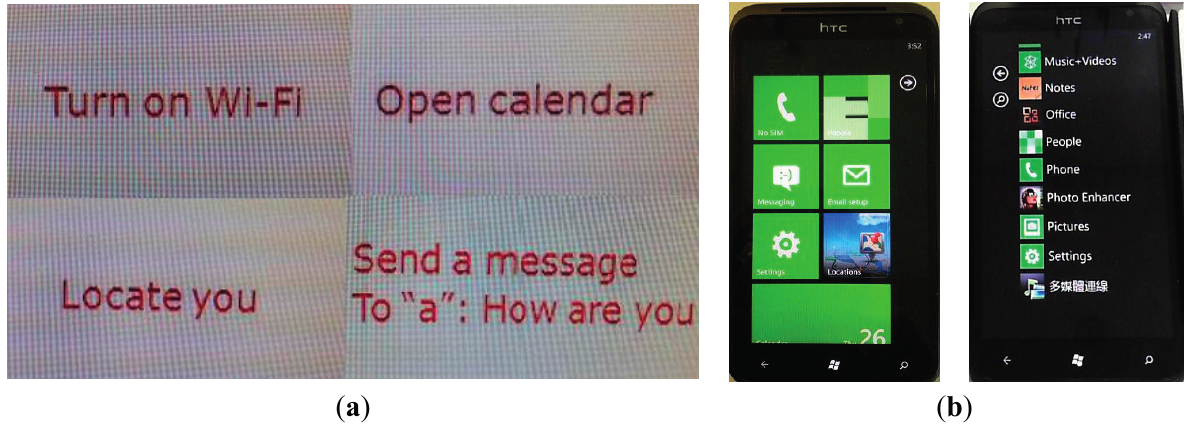
Figure 12. ( a ) Characters on the PC screen and ( b ) patterns and characters on the